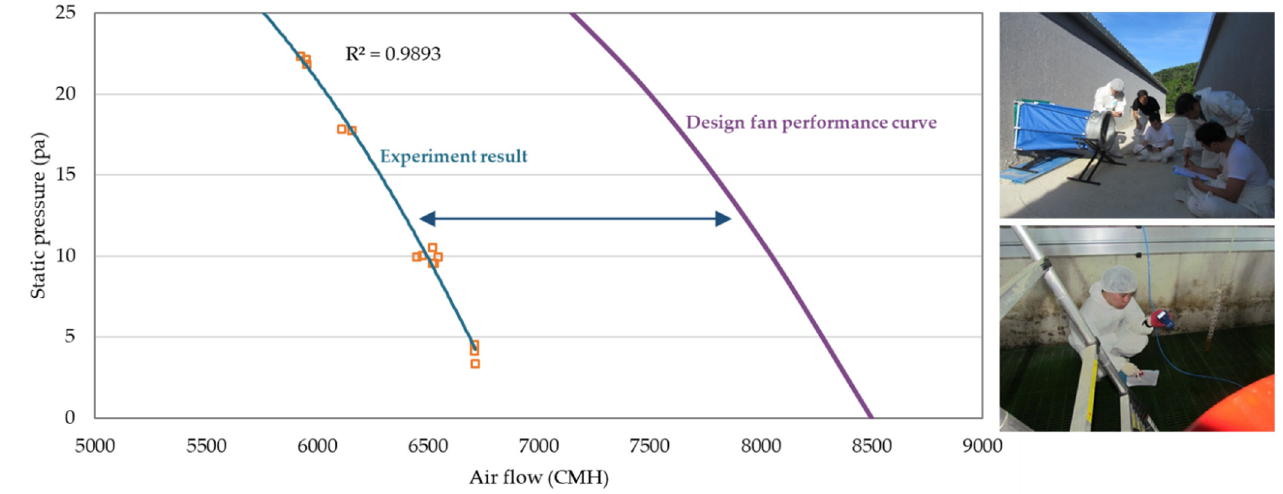
9 of 33 Figure 5. Installation location for each sensor inside the experimental pig house. △ P = ( 𝜌 𝜌 (cid:3031) )(𝑎 (cid:2868) 𝑤 (cid:2870) + 𝑎 (cid:2869) 𝑄𝑤 + 𝑎 (cid:2870) 𝑄 (cid:2870) )